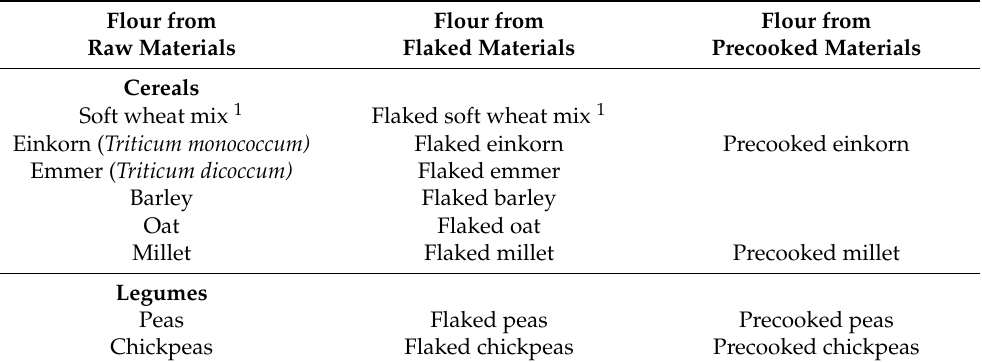
Table 1. List of collected and analyzed flour samples obtained from select ancient cereals and legumes. Flour from Raw Materials